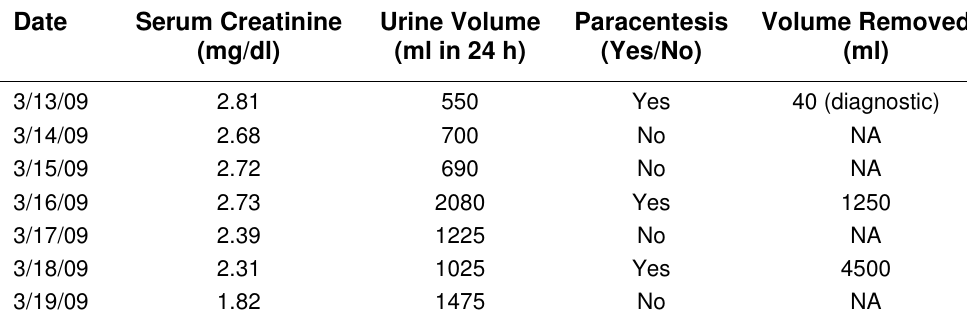
Daily Renal Function and Volume